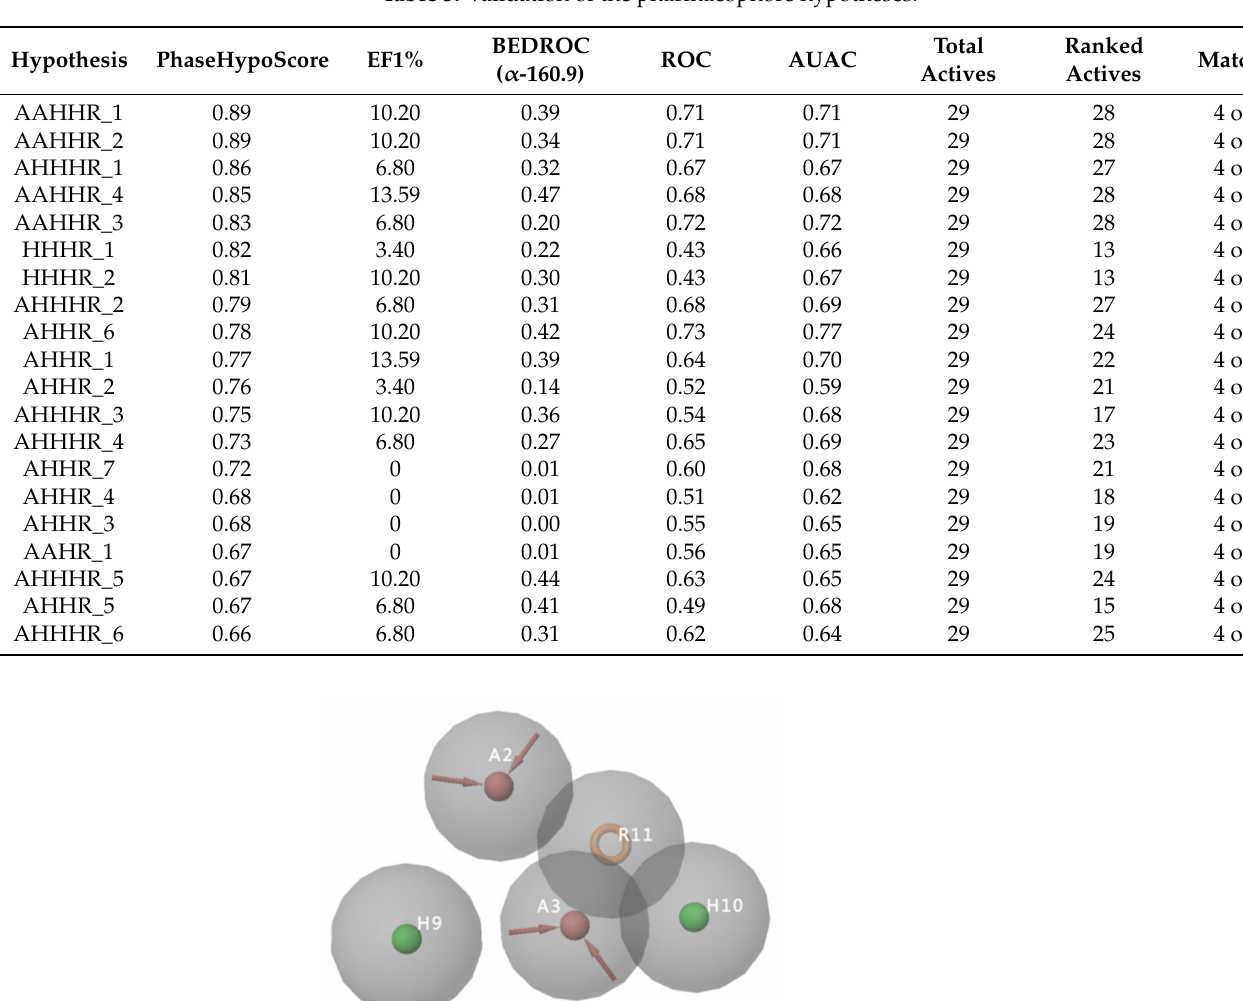
Table 3. Validation of the pharmacophore hypotheses.